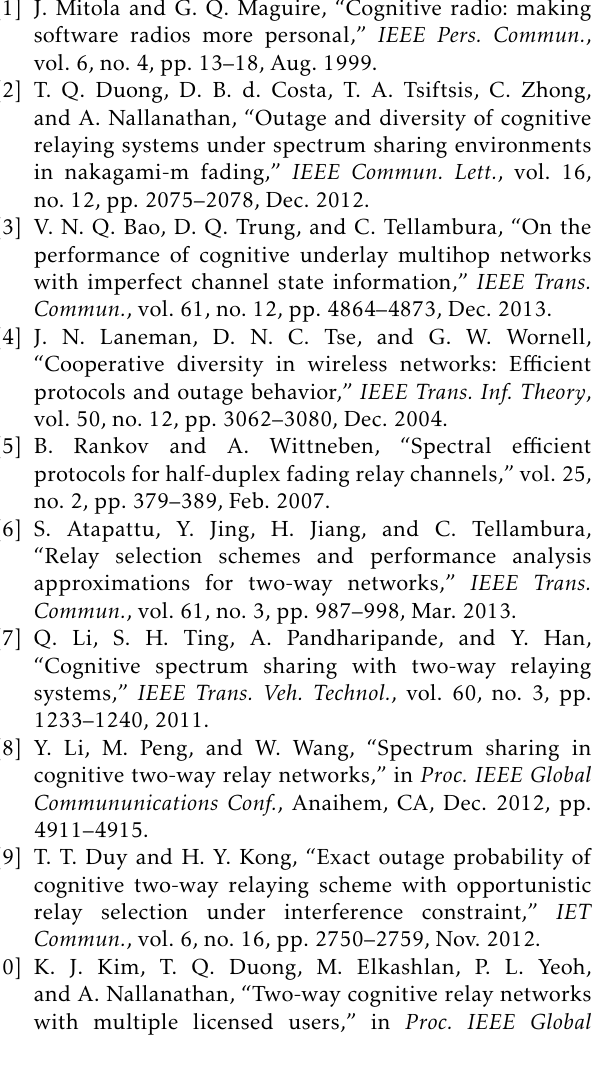
Figure 4. SOP of different diversity combining with R = 1 and η = 3 .